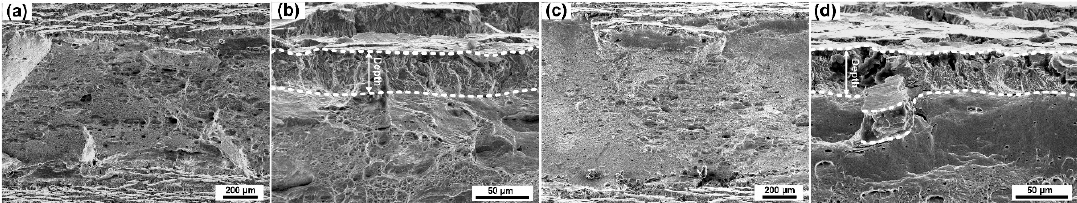
Figure 8. SEM surfaces of 316L specimens: ( a , b ) Un ‐ prestrained; ( c , d ) prestrained to 30% at 20 °C.